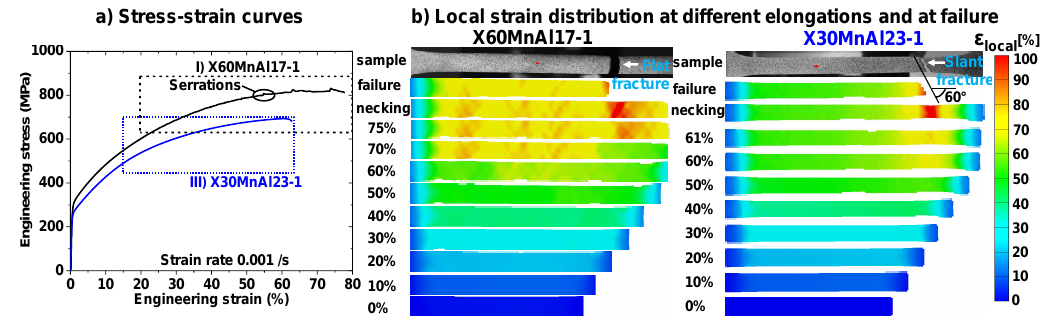
( a ) Stress-strain behavior extracted from the macroscopic tensile tests carried out in conjunction with digital image correlation (DIC). ( b ) Local strain distribution: X60MnAl17-1—Failure at the intersection of deformation bands with large strain localization (see also Figure 7k), X30MnAl23-1—Failure due to diffuse necking and large strain localization; rectangles indicate regions chosen to investigate deformation bands; left: macroscopic strain; right: legend for local von Mises effective plastic strain ( ε local ) distribution.